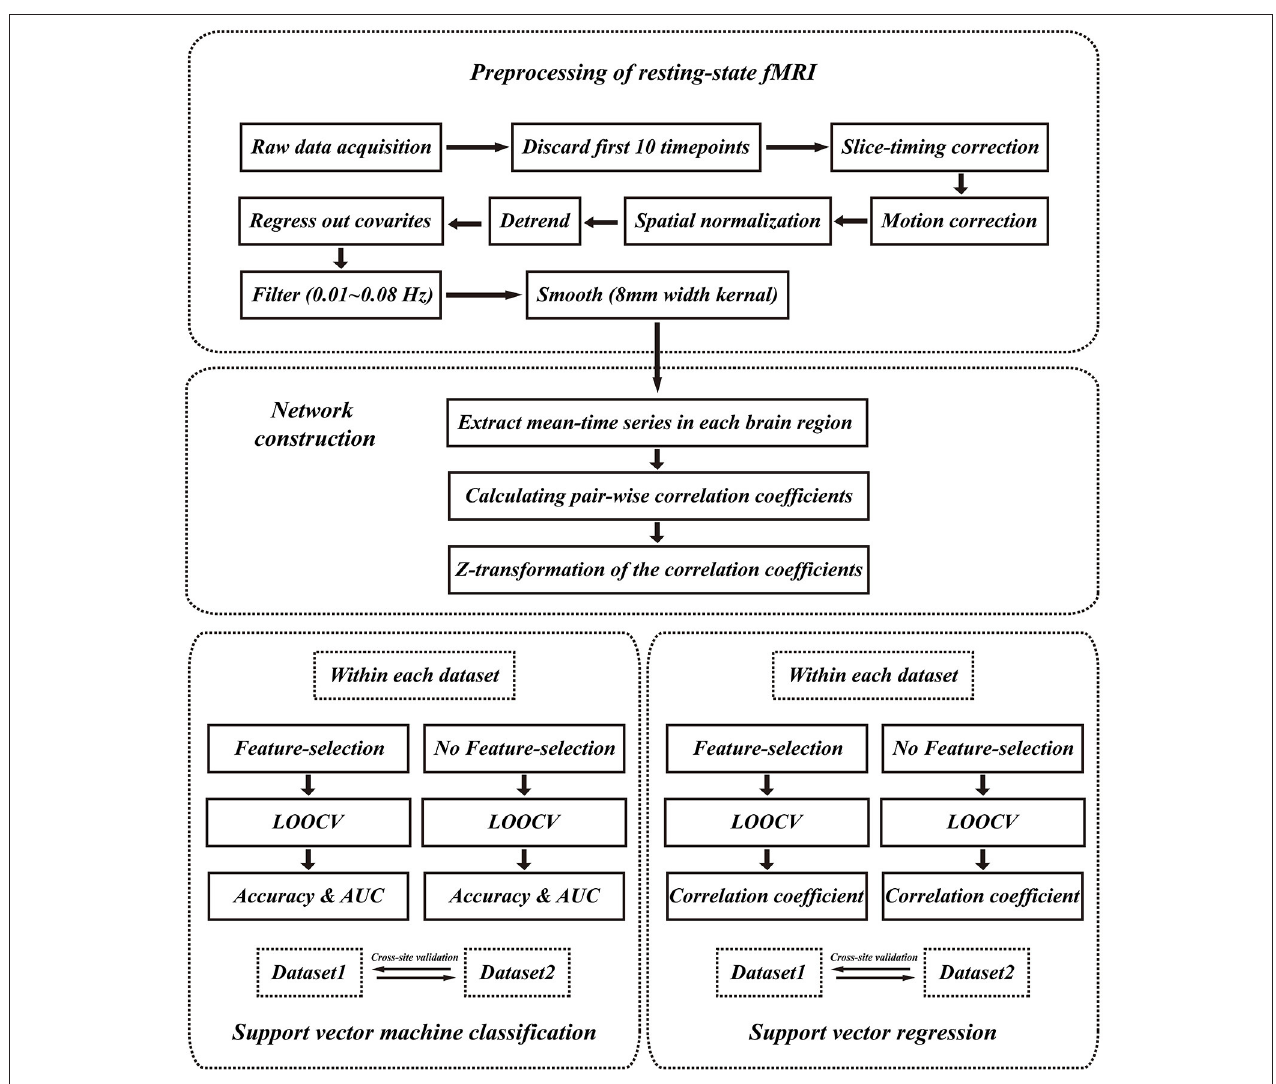
FIGURE 1 | Analysis pipeline. The analysis pipeline of our study. LOOCV, leave-one-out cross-validation.